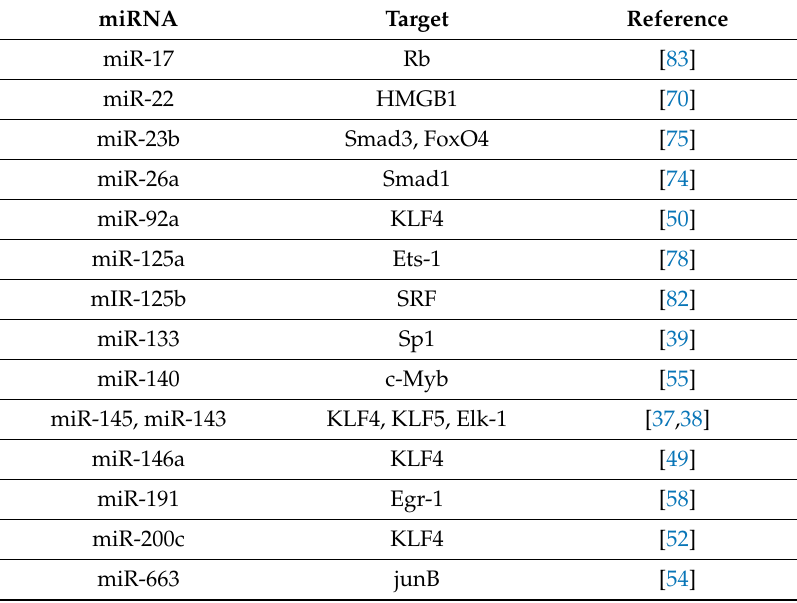
Table 1. Transcription factor regulation by miRNA in response to vascular injury. miRNA